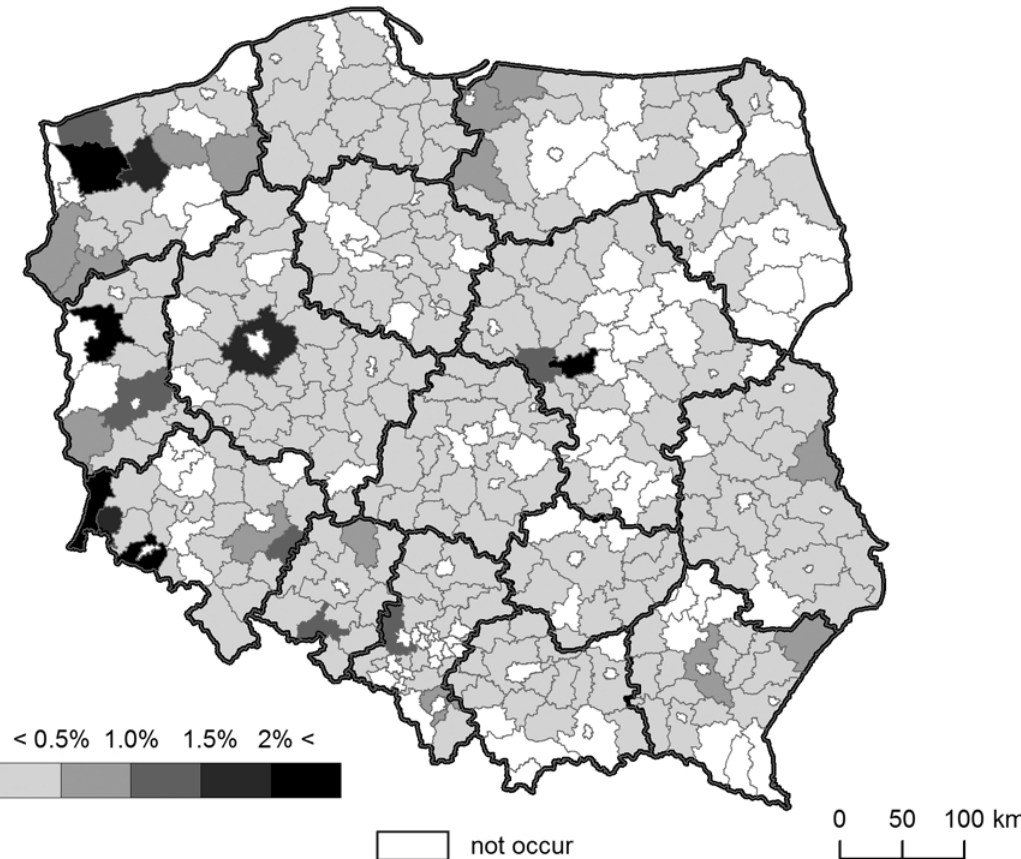
Fig. 1. Share of energy-crop plantations in the total area of agricultural holdings in poviats in Poland in 2010. Source: own study on the basis of the 2010 Agricultural